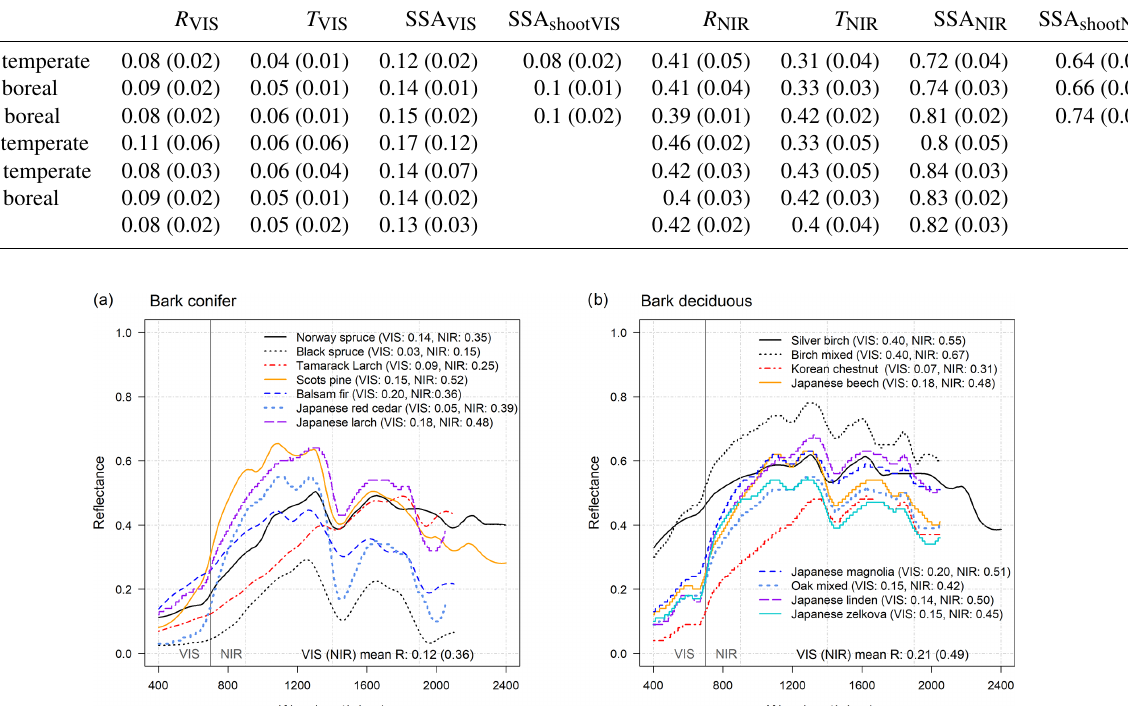
Table 3. Average leaf or needle reflectance ( R) , transmittance ( T ) , single scattering albedo (SSA), and single scattering albedo corrected for shoot-level clumping (SSA shoot ) over VIS (400–700nm) and NIR (701–2400nm) wavelength regions by plant functional type (PFT). Note that all VIS and NIR averages of R (λ) and T (λ) were weighted with solar irradiance spectra (SI (λ) ) . Standard error is given inside parentheses.